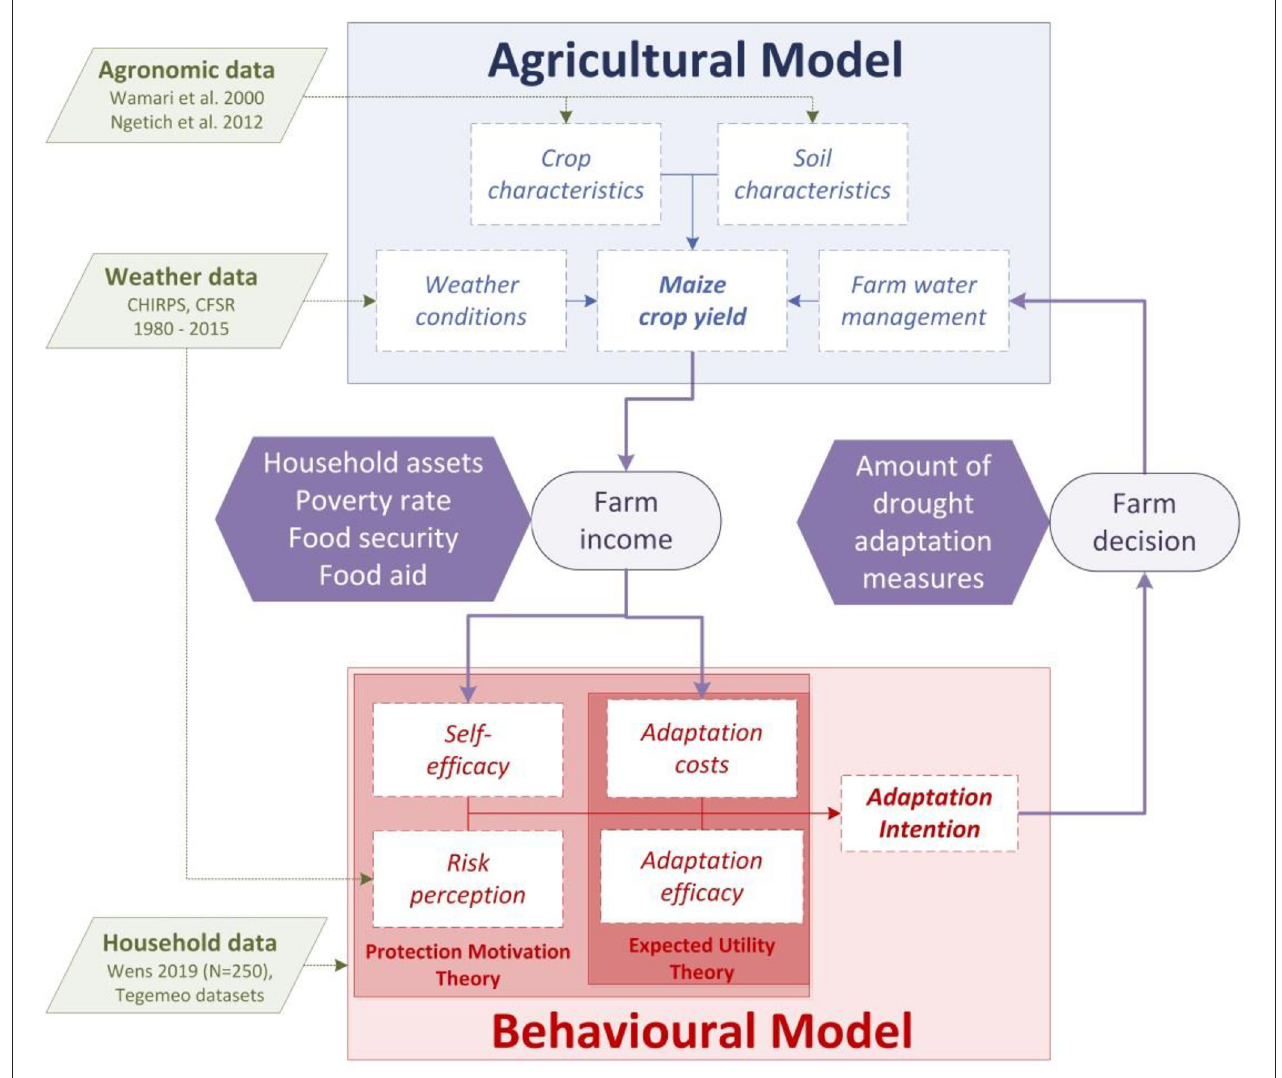
FIGURE 1 | Modeling scheme of the agricultural drought risk adaptation model ADOPT. Seasonal maize crop production is simulated using weather and agronomic data in AquacropOS at the household scale (Blue). The resulting household maize yield is translated into farm income, which is fed into a behavioral model (Red). Adaptive behavior is modeled per farm household using one of three scenarios: No adaptive behavior, economic rational adaptive behavior, or bounded rational behavior. Following expected utility theory, the intention to adapt is modeled to be a function of Adaptation costs, adaptation efficacy, and household assets. Following protection motivation theory, the intention to adapt is a function of risk perception, self-efficacy, adaptation costs, and adaptation efficacy. The individual farm households’ intention to adapt leads to the yearly decision whether or not to adopt a new adaptation measure. These adaptation decisions influence their future on-farm water management, thus establishing a feedback. Survey, weather, and agronomic data used as input to the model (Green), whereas yearly risk indicators (household assets, poverty, food insecurity, and food aid) and the adoption rate of drought adaptation measures are outputs of the model